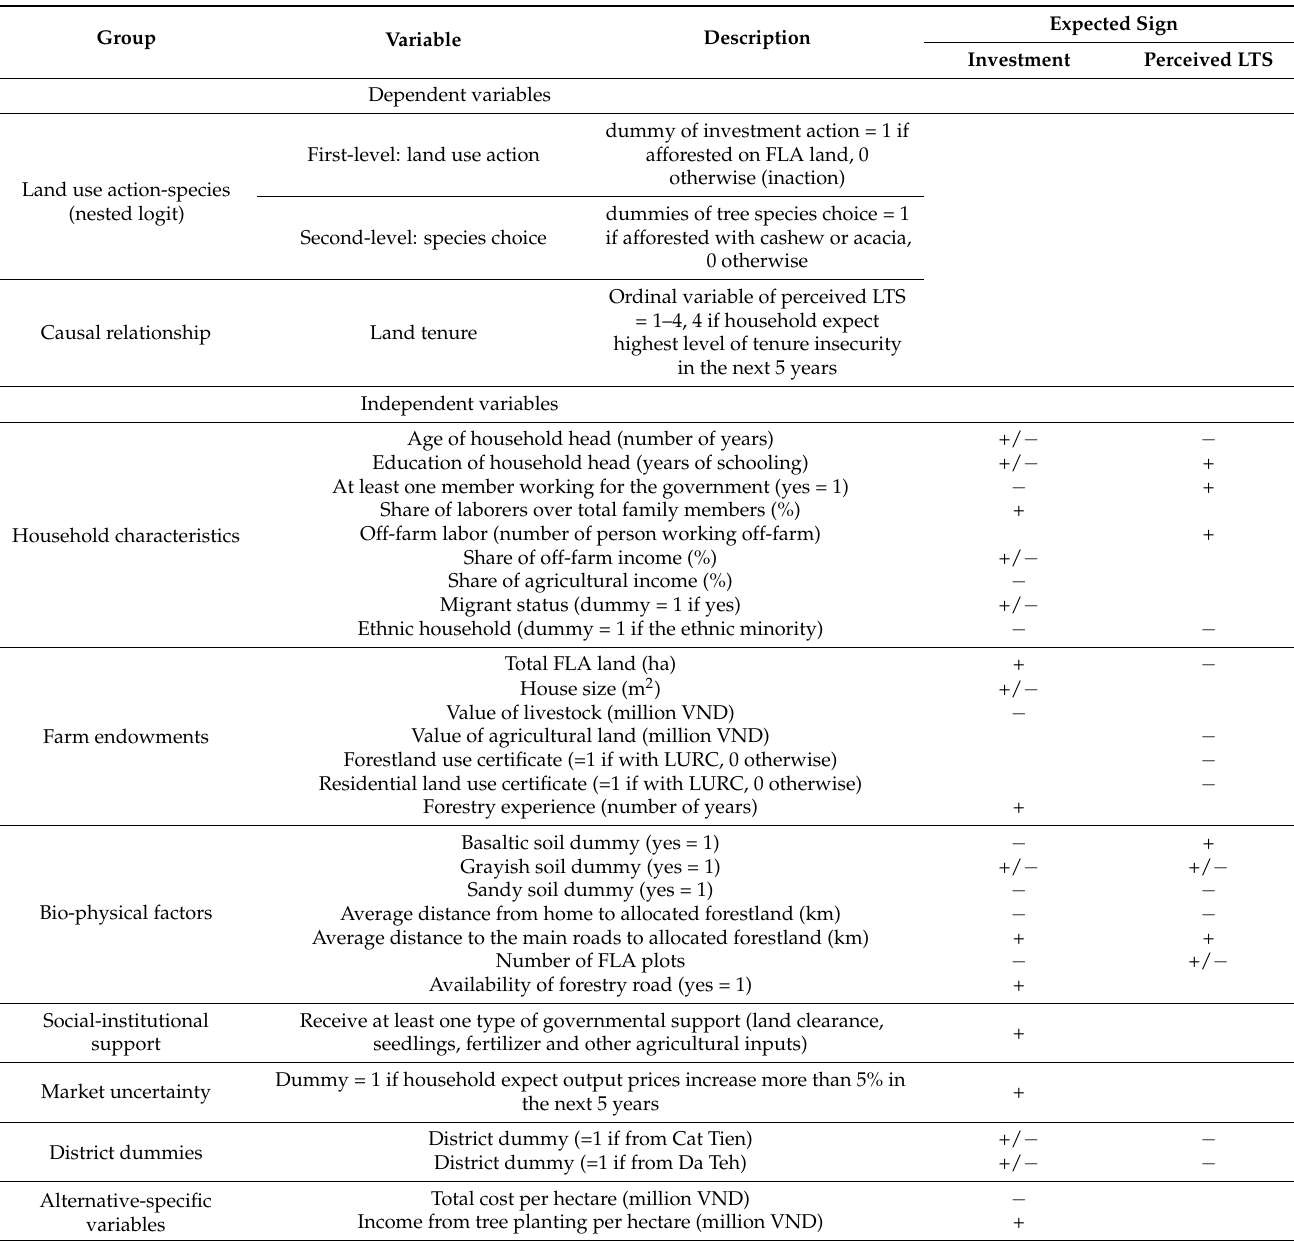
Table 2. Variable description in the Nested Logit and Ordered Probit